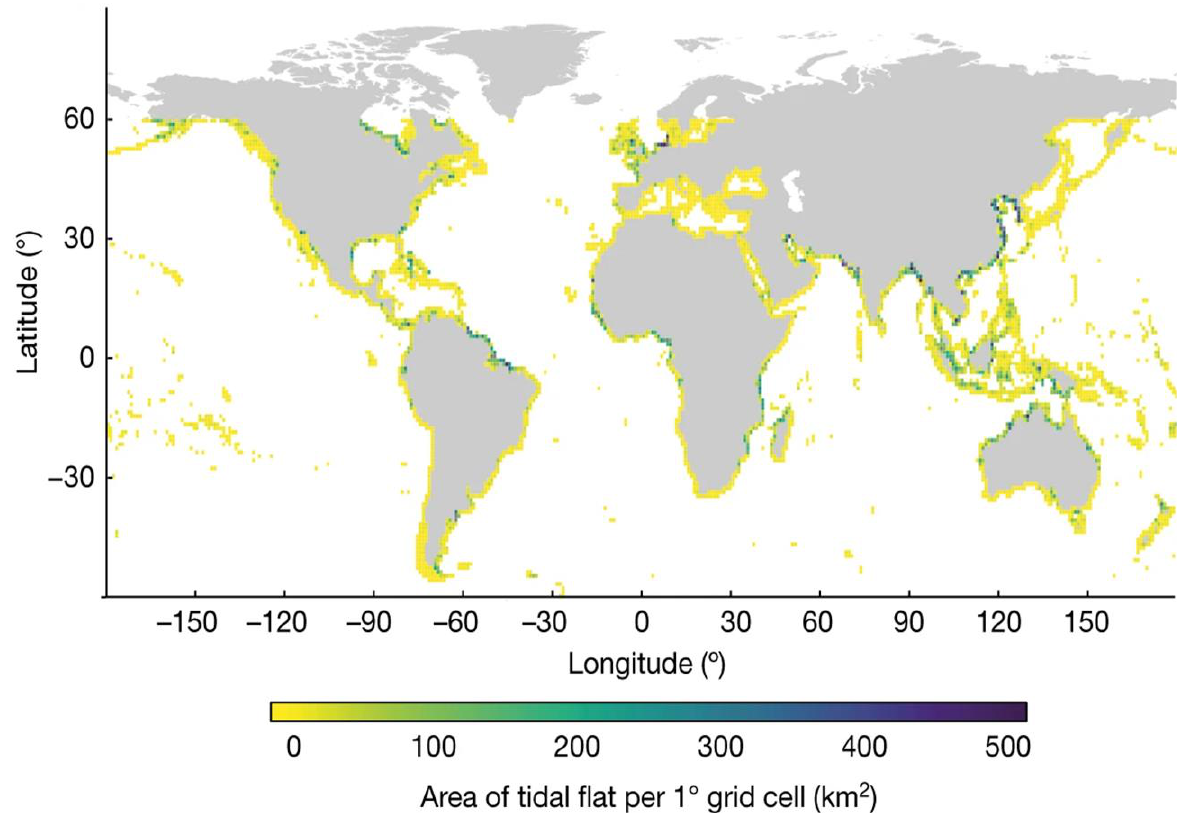
Figure 8. Global distribution of tidal flats during 2014 – 2016. The figure is directly adopted from Ref. [9]. Reference